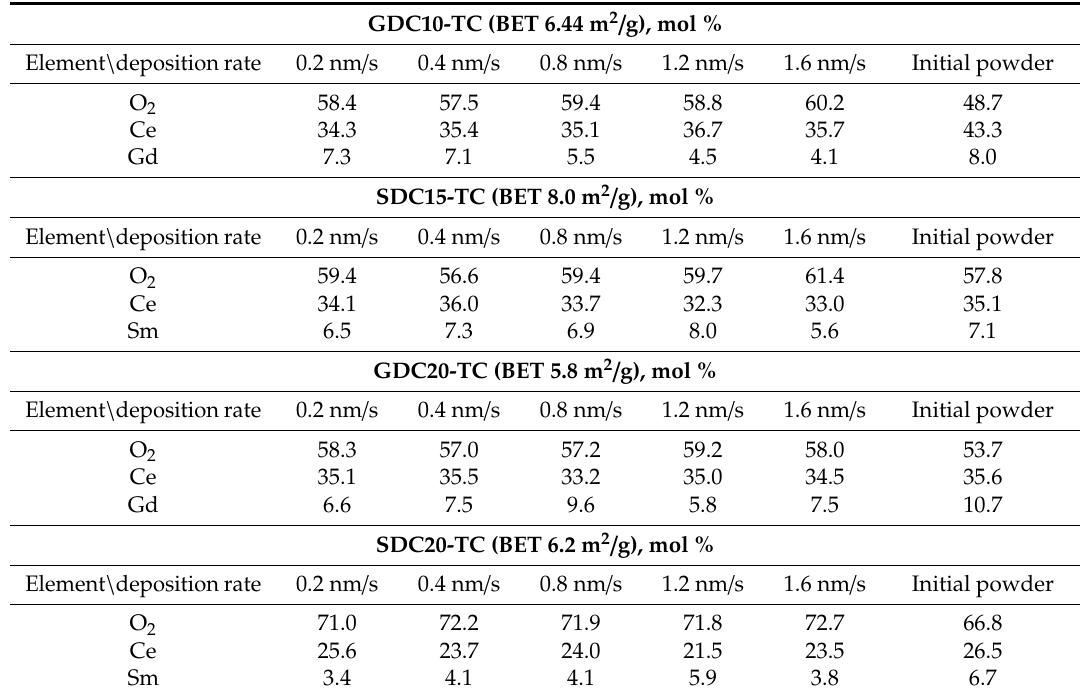
Table 1. Elemental concentration of deposited thin films (600 ◦ C deposition temperature).